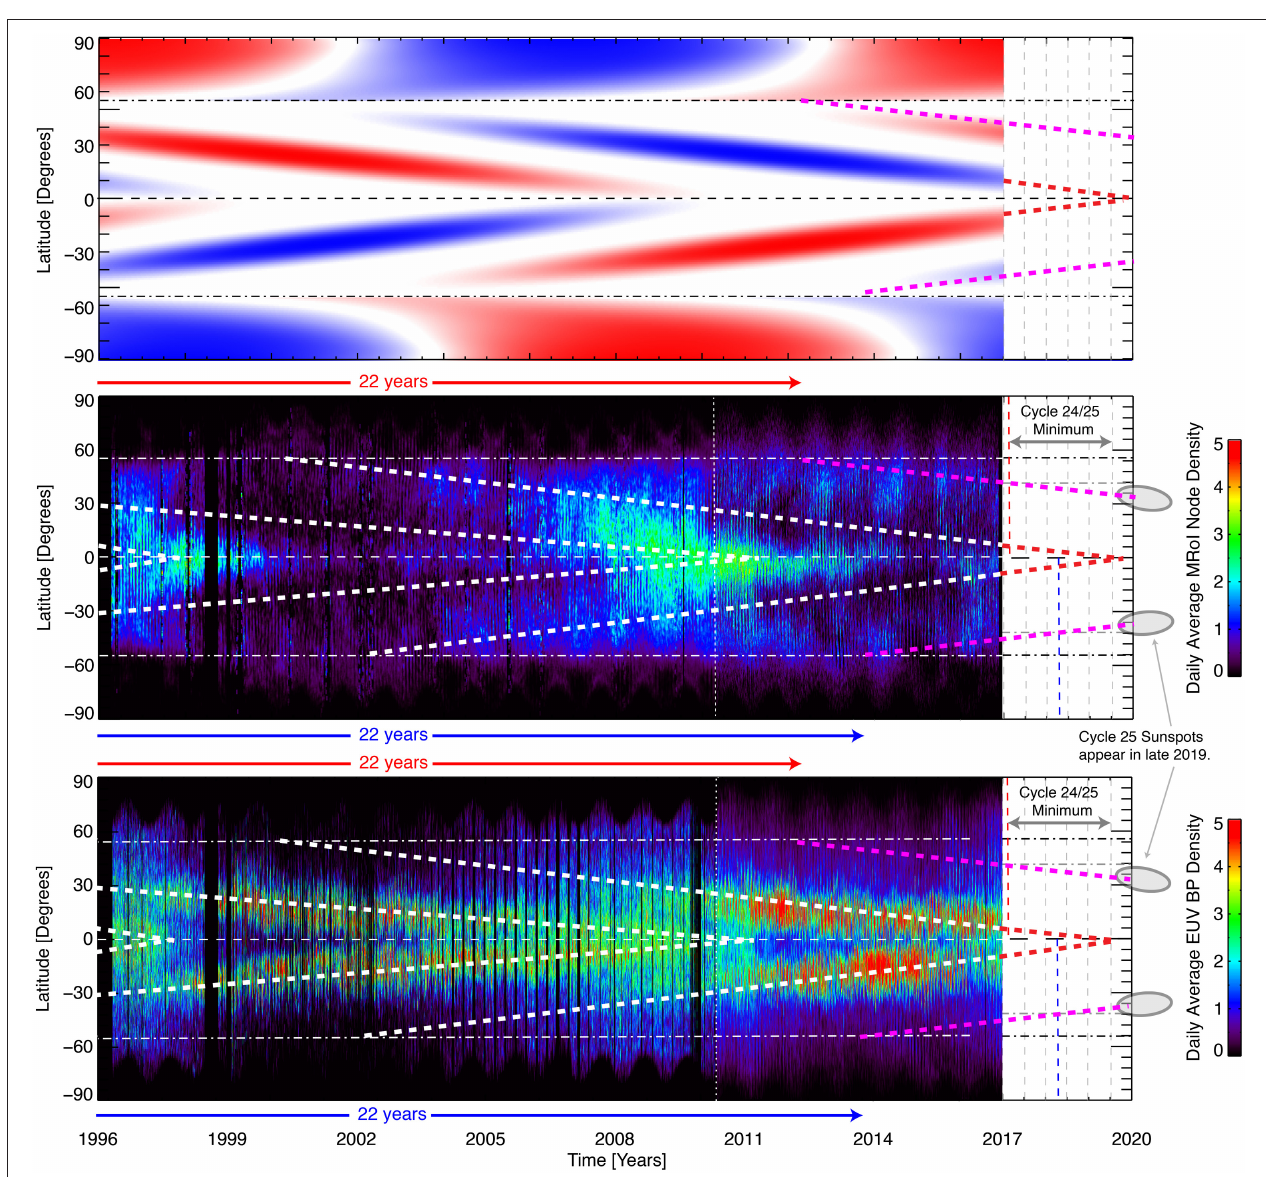
FIGURE 3 | As for Figure 1 with the g-node (Center) and BP (Bottom) density diagnostics updated to the end of 2016 and the updated band-o-gram (Top) . We see that the magnetic bands of solar cycle 25 not only appeared where and when anticipated, but that they appear to be following the mean migratory speeds inferred by McIntosh et al.